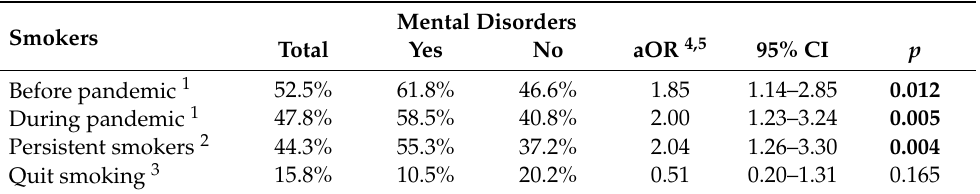
Table 3. Smoking behaviors before and during the COVID-19 pandemic among participants with and without mental